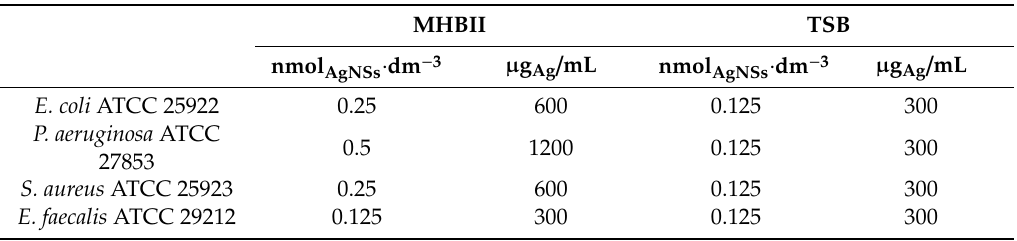
Table 1. Minimum inhibitory concentration (MIC) values of AgNSs determined in MHBII and TSB media against Gram-positive and Gram-negative